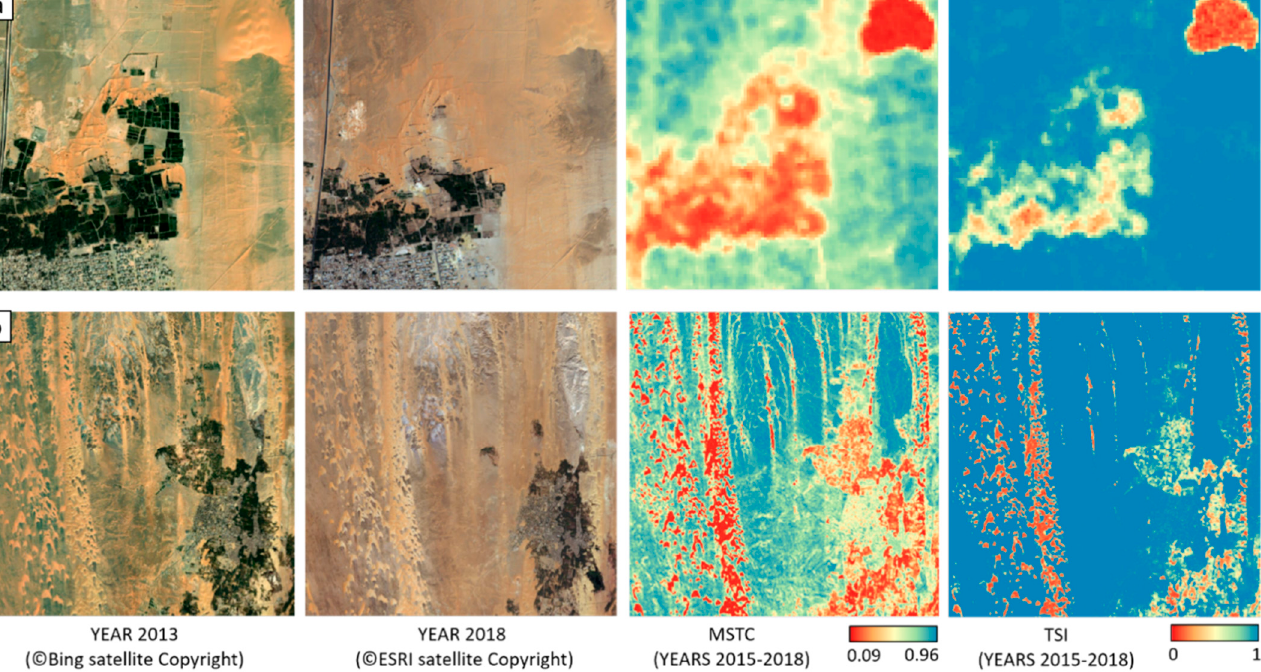
Figure 11. Interferometric phase computed between 25 June 2018 and 7 July 2018. On the left, the whole area of interest is presented; on the right, a detail of dunes near El-Kharga shows displacements less than 6 cm in 12 days. Basemap: © Google 2019 Copyright.